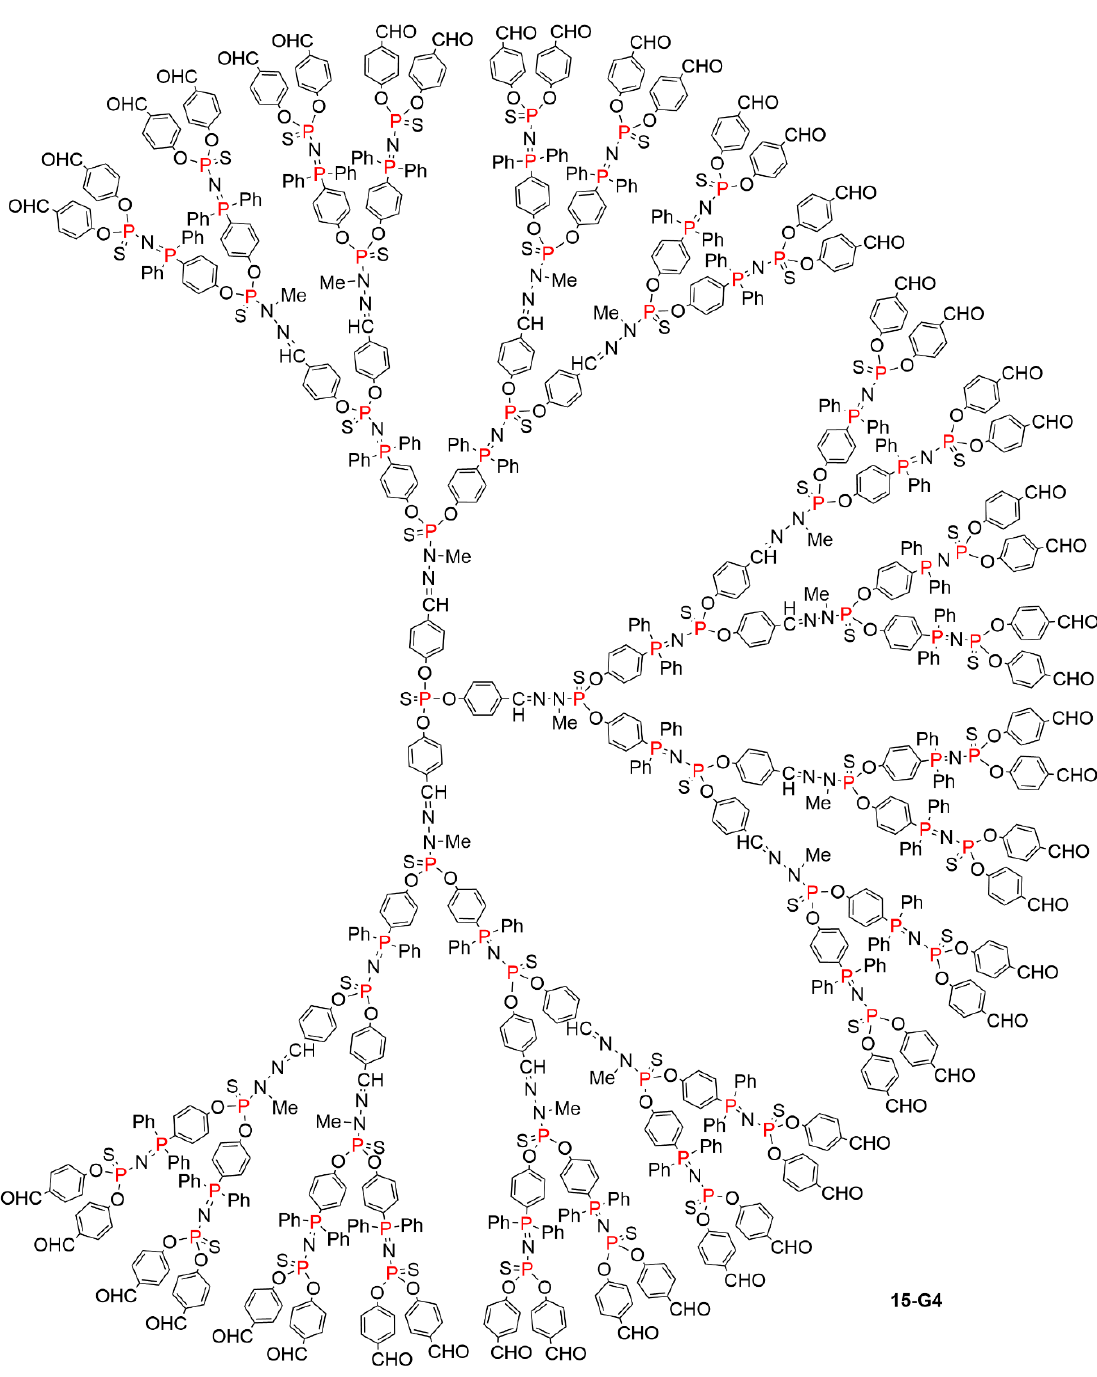
Figure 10. Full chemical structure of the layered dendrimer 15-G4 , for which the linear structure is shown in Scheme 15.